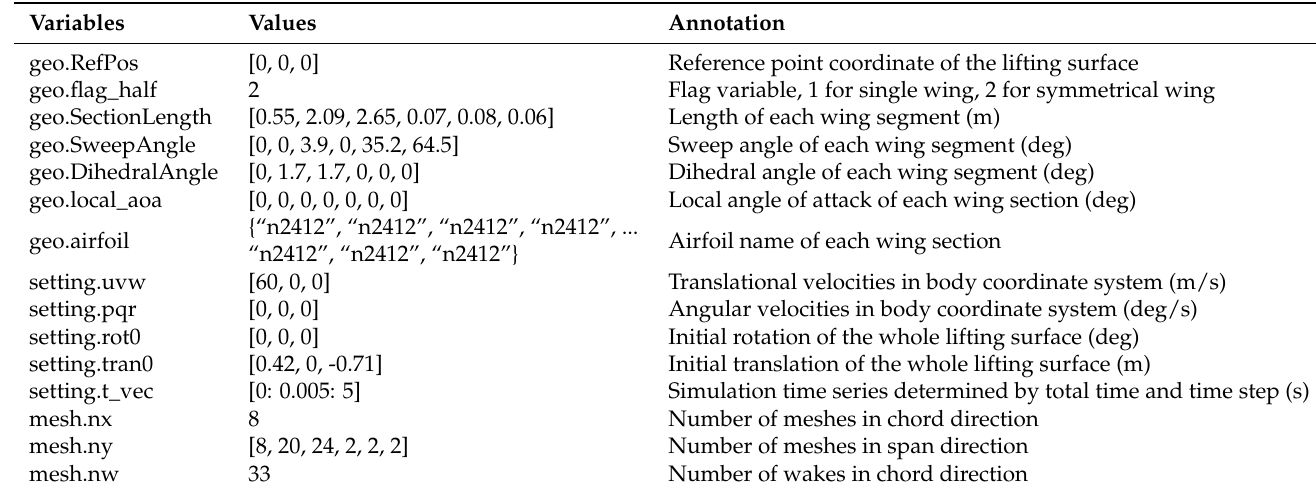
Table 2. Input data of the main wing of the Cessna 172.